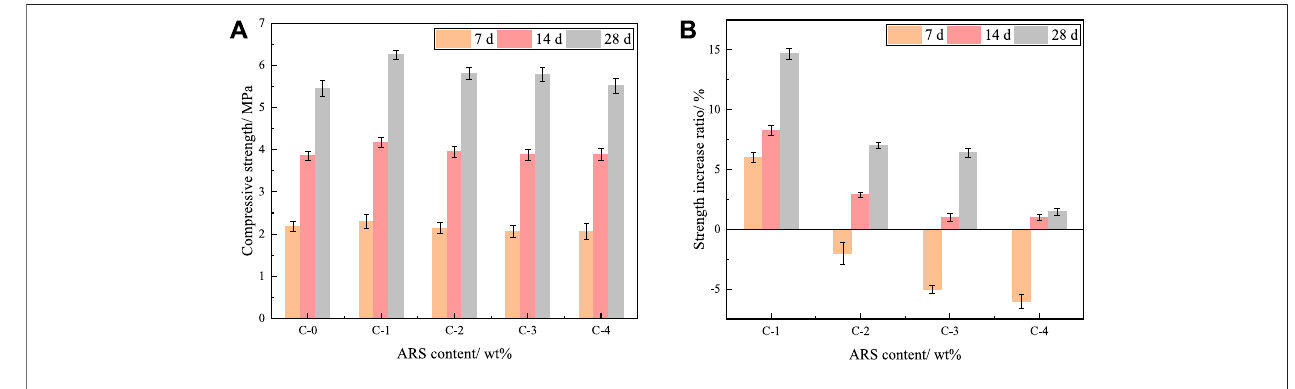
FIGURE 4 | The UCS of CTB and